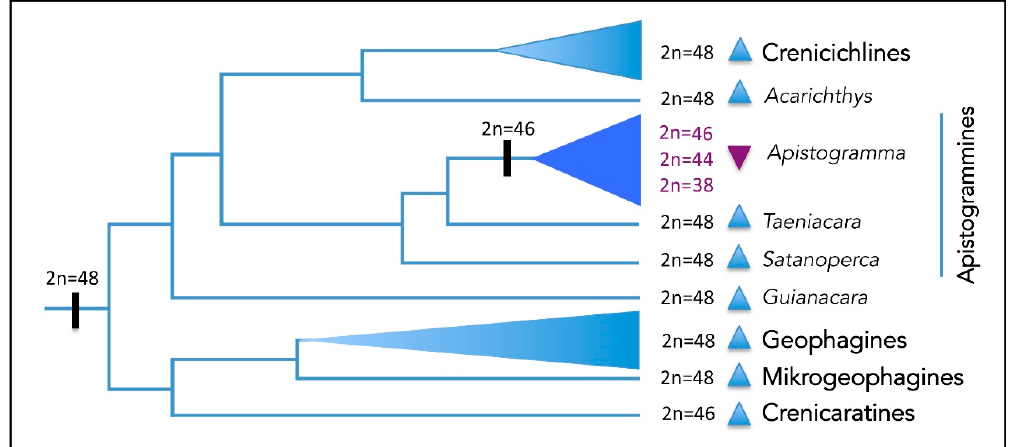
Figure 6. Diploid numbers (2n) and karyotype structure of Geophagini groups under a phylogenetic perspective [7]. Blue triangles represent karyotypes with >50% acrocentric chromosomes shared by several Cichlinae clades and some Apistogrammines groups; the purple triangle shows the exclusive diploid set found for the genus Apistogramma , characterized by a reduced chromosome number with <50% acrocentric chromosomes. < 50% acrocentric